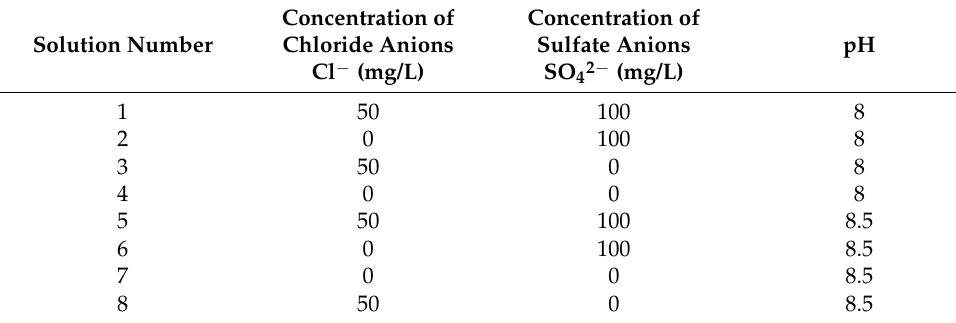
Table 3. Composition of solutions used in electrochemical testing.